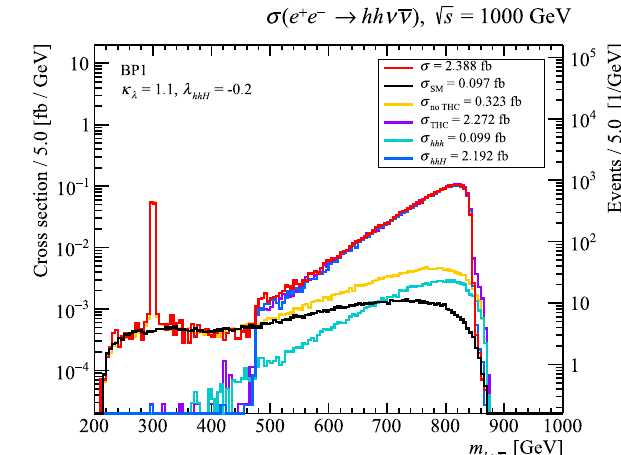
√ s = 1000 GeV for BP1. The Higgs boson h in these two invariant mass variables m hZ and m h ν ¯ ν refer to the less energetic Higgs boson of the final